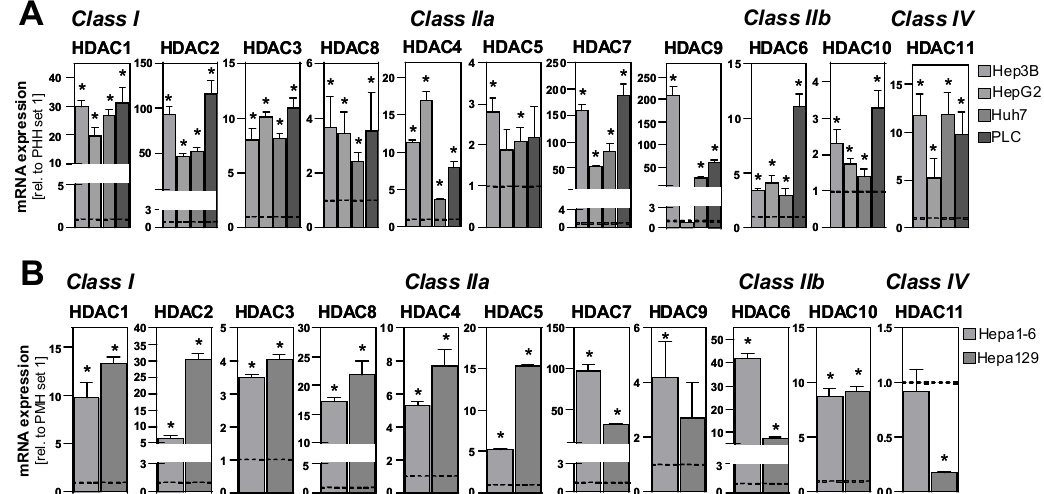
Figure 1. Histone deacetylase (HDAC) expression in hepatocellular carcinoma (HCC) cells compared with hepatocytes. ( A ) HDAC mRNA expression levels in four human HCC cell lines (Hep3B, HepG2, Huh7 and PLC) relative to expression in primary human hepatocytes (PHHs; set at a value of 1). ( B ) HDAC mRNA expression in two murine HCC cell lines (Hepa1-6 and Hepa129) relative to expression in primary murine hepatocytes (PMH; set at a value of 1). (*: p < 0.05 compared to PHH or PMH.). The expression levels of different HDACs in HCC patients were analyzed using the Oncomine TM human cancer microarray database [20]. In one dataset comprising 445 HCC patients (Roessler Liver 2 [21]), HDAC 1, 2 (class I) and HDAC 4 , 5 and 9 (class IIa) but not HDAC 3, 6 and 11 were found to